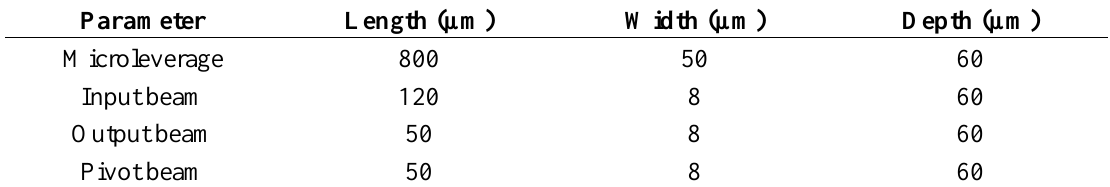
Table 2. The parameters of the microleverage mechanism.